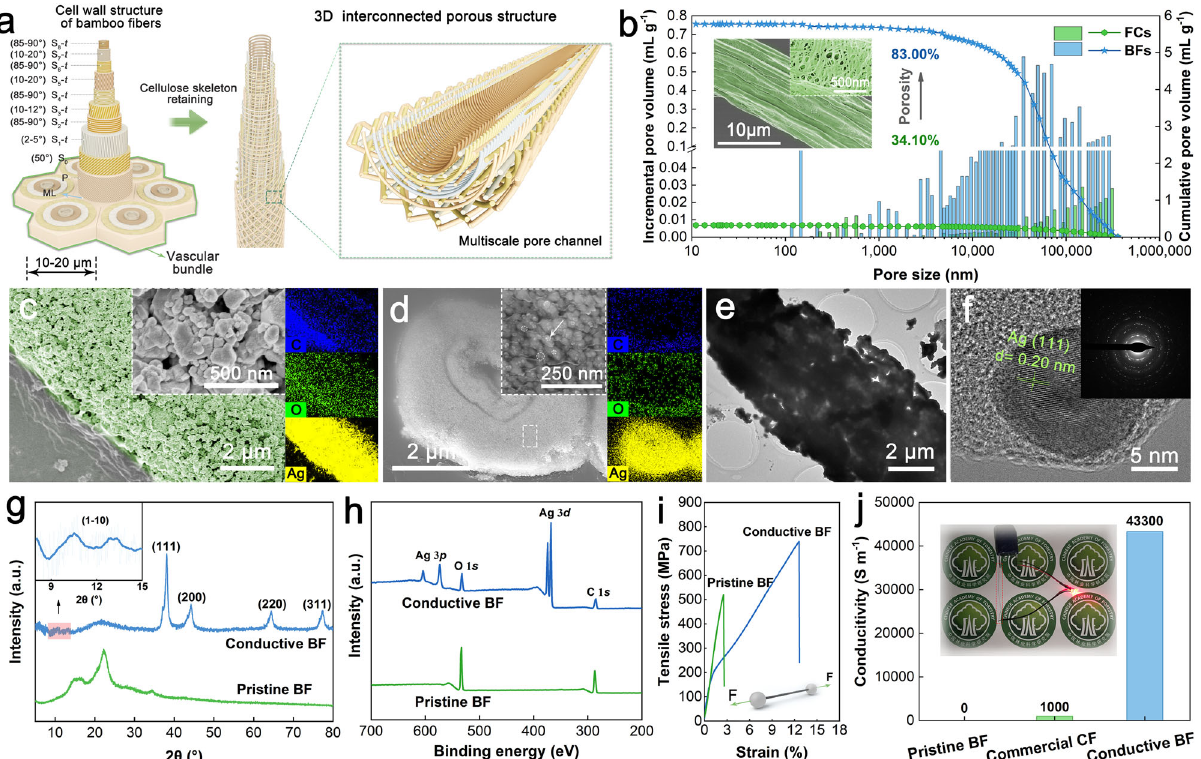
Fig. 2 Structure and electrical conductivity of the Ag-coated BFs. a Diagram of cell wall structure of bamboo fi bers and the hollow 3D interconnected porous structure after cellulose skeleton retaining process. b The incremental pore volume of pore distribution and cumulative pore volume of pore distribution of FCs and BFs; inset: arti fi cial-color SEM images of the pristine BF. c Arti fi cial-color SEM images of the conductive BF; inset: element maps of C, O, and Ag for the sample. d SEM images of the cross-section, magni fi ed image and elemental maps of C, O, and Ag of an Ag-coated BF e TEM image of conductive BF. f HRTEM image of an individual Ag NP after dispersion, showing the (111) lattice plane of Ag; inset: corresponding SAED image. g XRD patterns; inset: the local enlarged region (2 θ = 8 – 15°), h XPS pro fi les, and i stress – strain curves of pristine and conductive BFs. j Conductivity of pristine BF (0 S m − 1 ), commercial CF (1000 S m − 1 ), and our conductive BF (43300 S m − 1 ); inset: a single conductive BF bundle used as a wire to light an